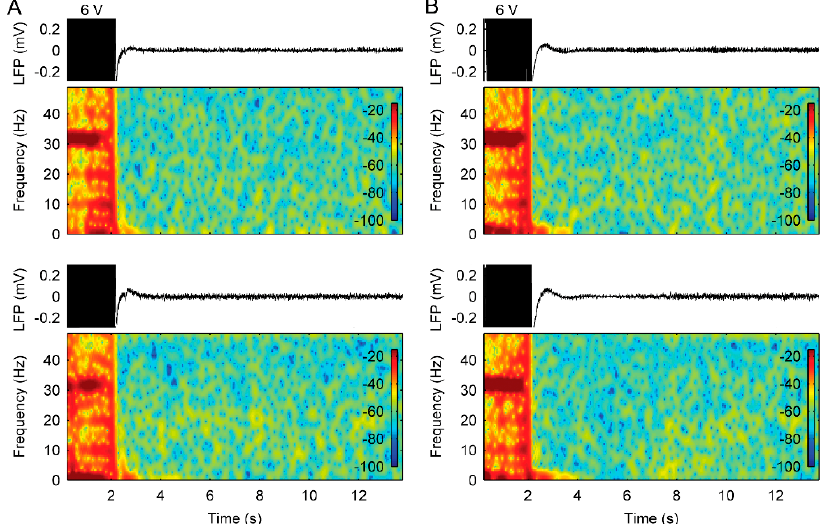
Figure 7. Long-term effects of bilateral therapeutic stimulation with an 8 s ramp on the LFP recordings in the bilateral ACC from patient 1. ( A ) Raw LFP recordings and corresponding spectrograms in the left (top panels) and right ACC (bottom panels) during stimulation for 5 months. ( B ) Raw LFP recordings and corresponding spectrograms in the left (top panels) and right ACC (bottom panels) during stimulation for 9 months.